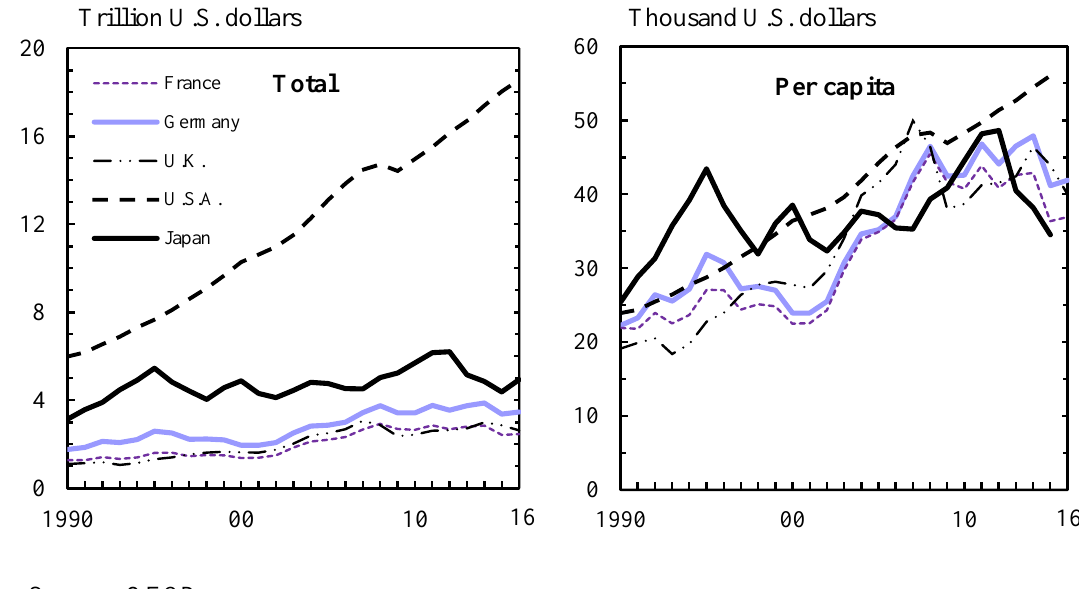
Gross Domestic Product (Nominal prices, converted into U.S.